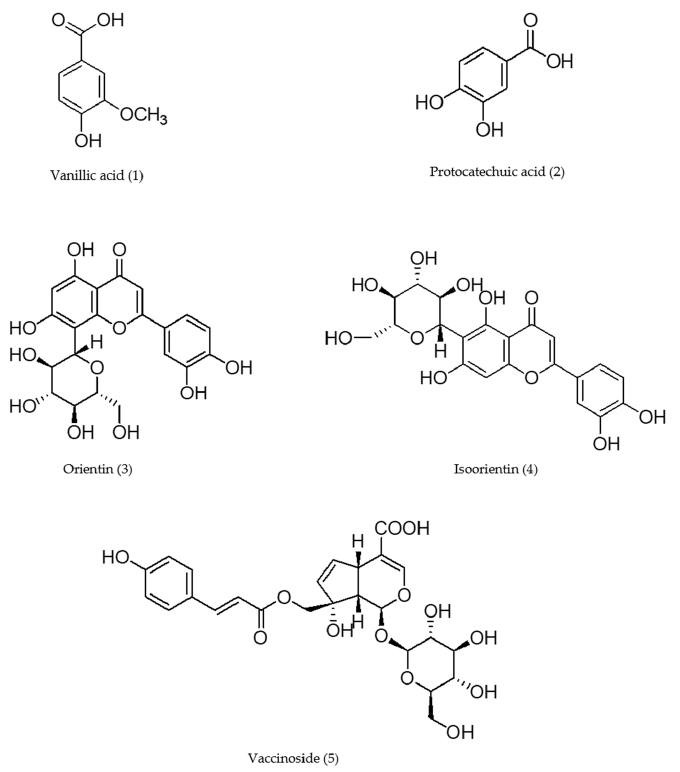
Figure 2. Structures of compounds isolated from Vaccinium bracteatum Thunb. in Korea.